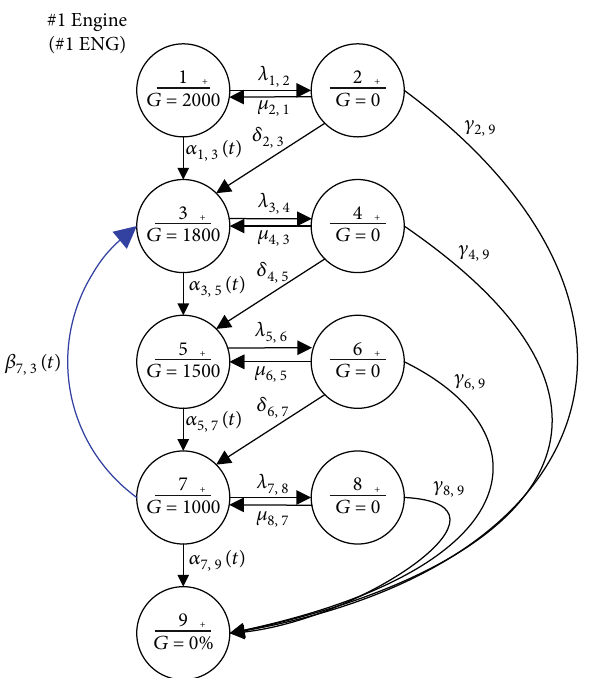
Figure 10: State-transition diagram of No. 1 engine.